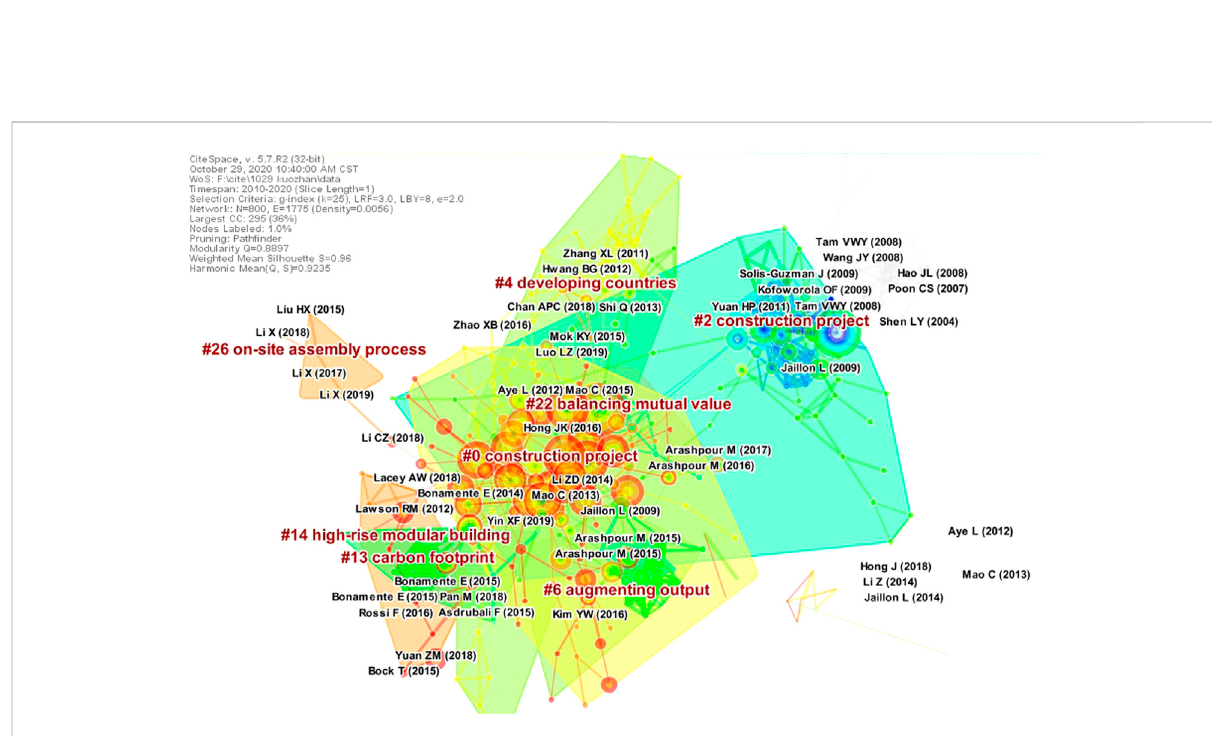
FIGURE 9 Co-cited of extending research cluster